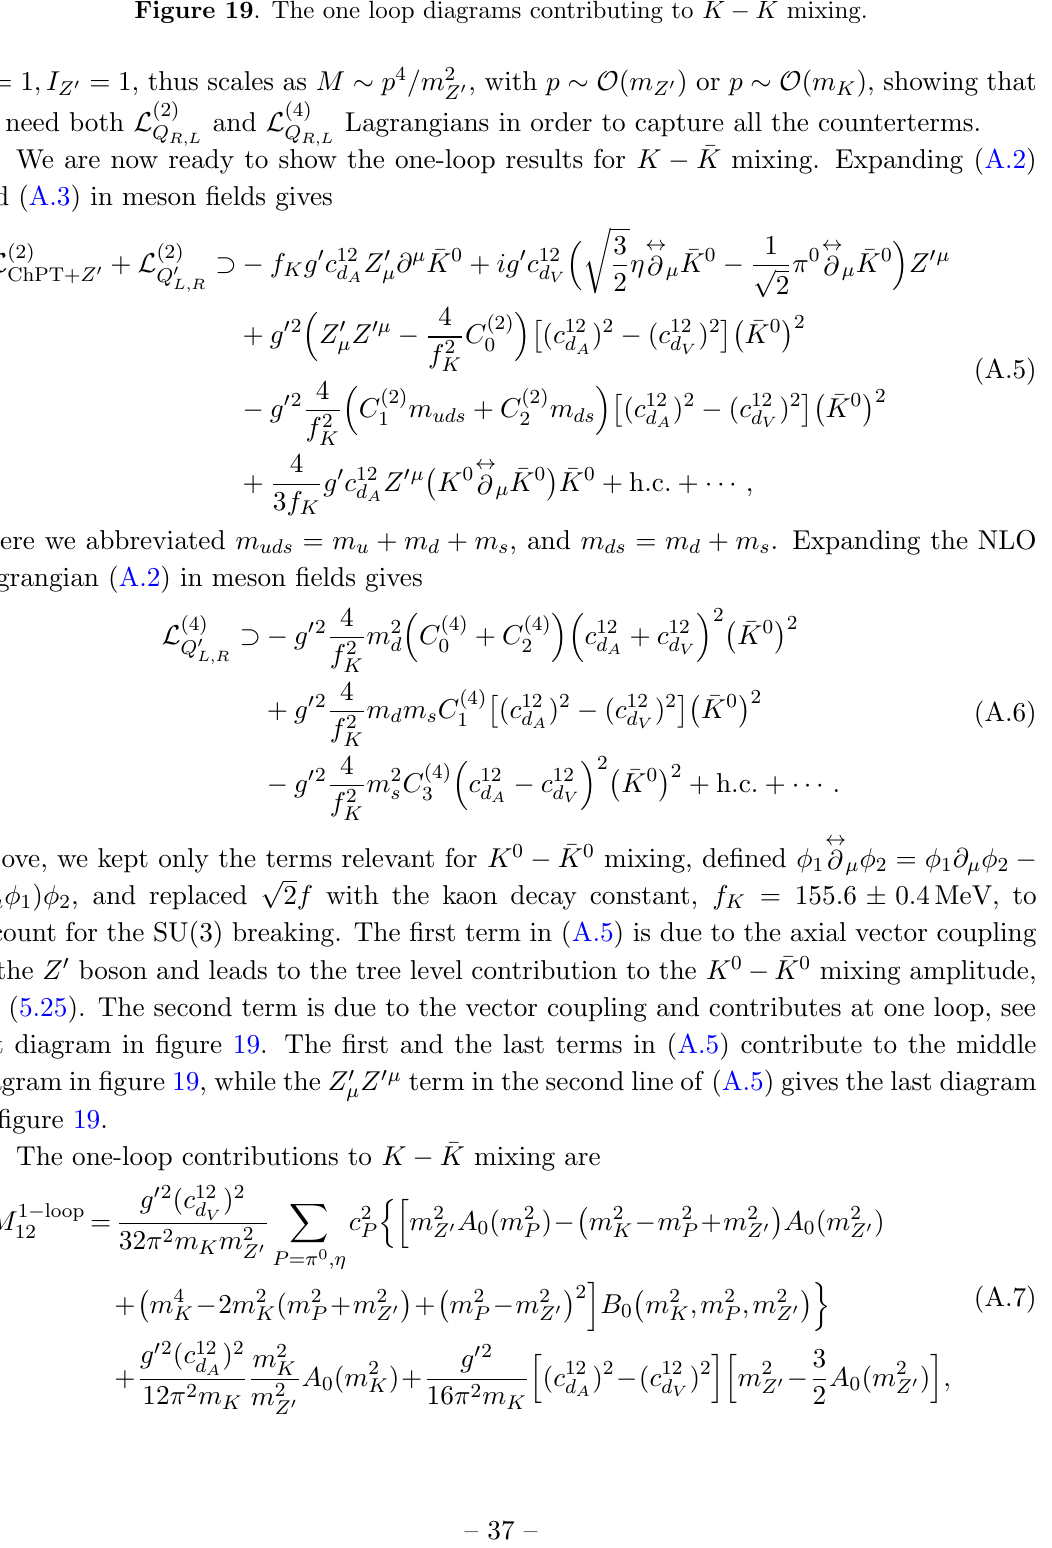
Figure 19 . The one loop diagrams contributing to K